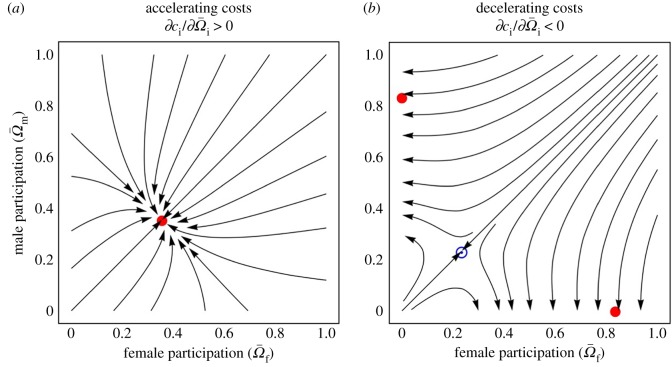
Evolution of male and female participation in the absence of other sex differences in the ecology of war. Streamline plots showing the evolution of male and female participation in warfare  with accelerating personal costs (a) and with decelerating personal costs (b). Filled red circles represent stable equilibria and circled blue dots represent unstable equilibria. For the purposes of illustration, we assume competitiveness functional forms  (a), and  (b), and a symmetrical war outcome function , where  and  are the fighting strengths of the attacker and the defender, respectively (see electronic supplementary material for details), with ψf = ψm = 1 and χf = χm = 0.12. Other parameter values are , , Nf = Nm = 10, mm = mf = 0.5, sf = sm = 0.15. (Online version in colour.)